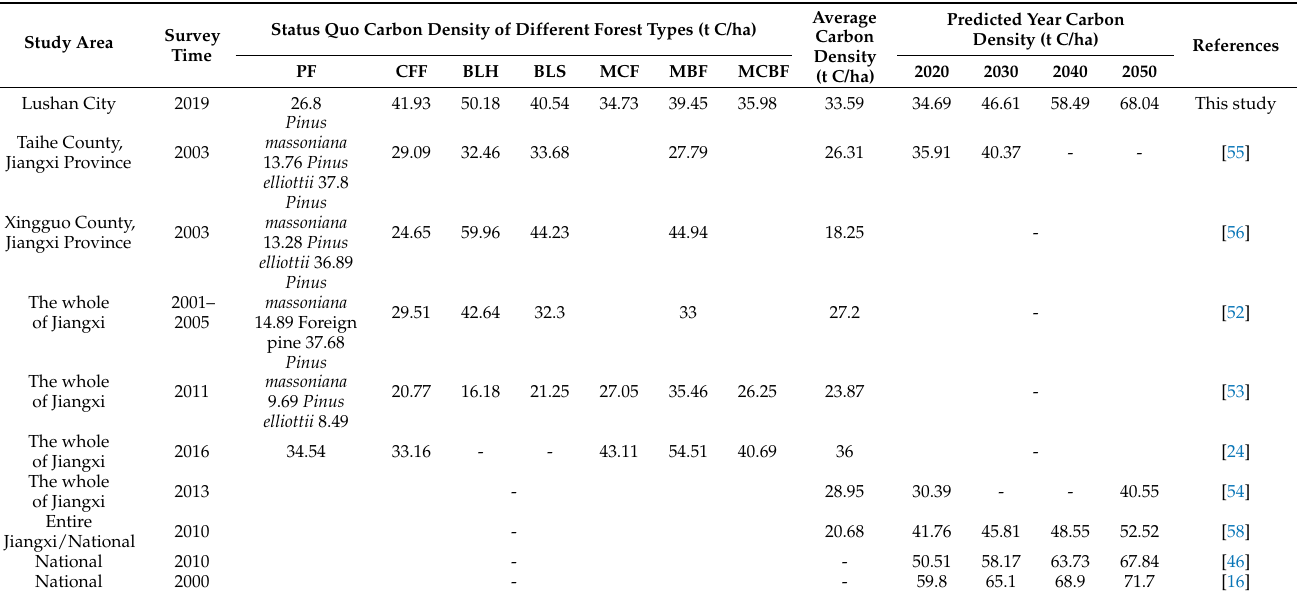
Table 5. Comparison with the estimated and predicted values of forest carbon density in Jiangxi Province from previous